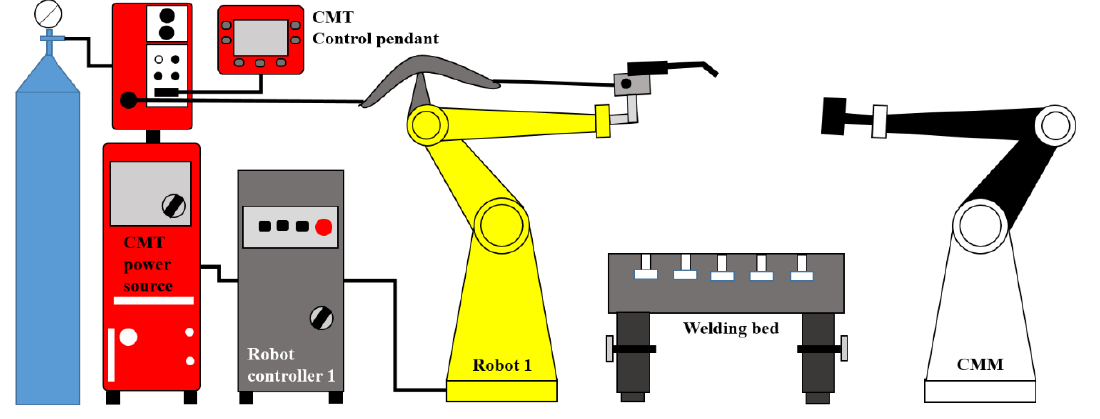
Figure 5. Environment of the experimental set-up.